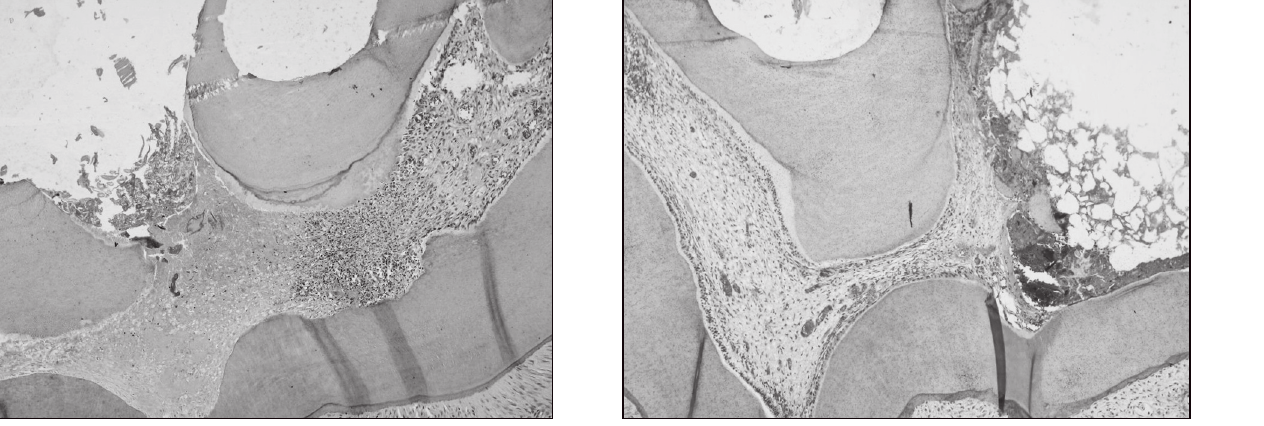
Figure 2 - Photomicrograph of a rat tooth 24 hours after pulpotomy and pulp capping with iodoform paste showing light presence of inflammatory infiltrate (HE, 100 × ).